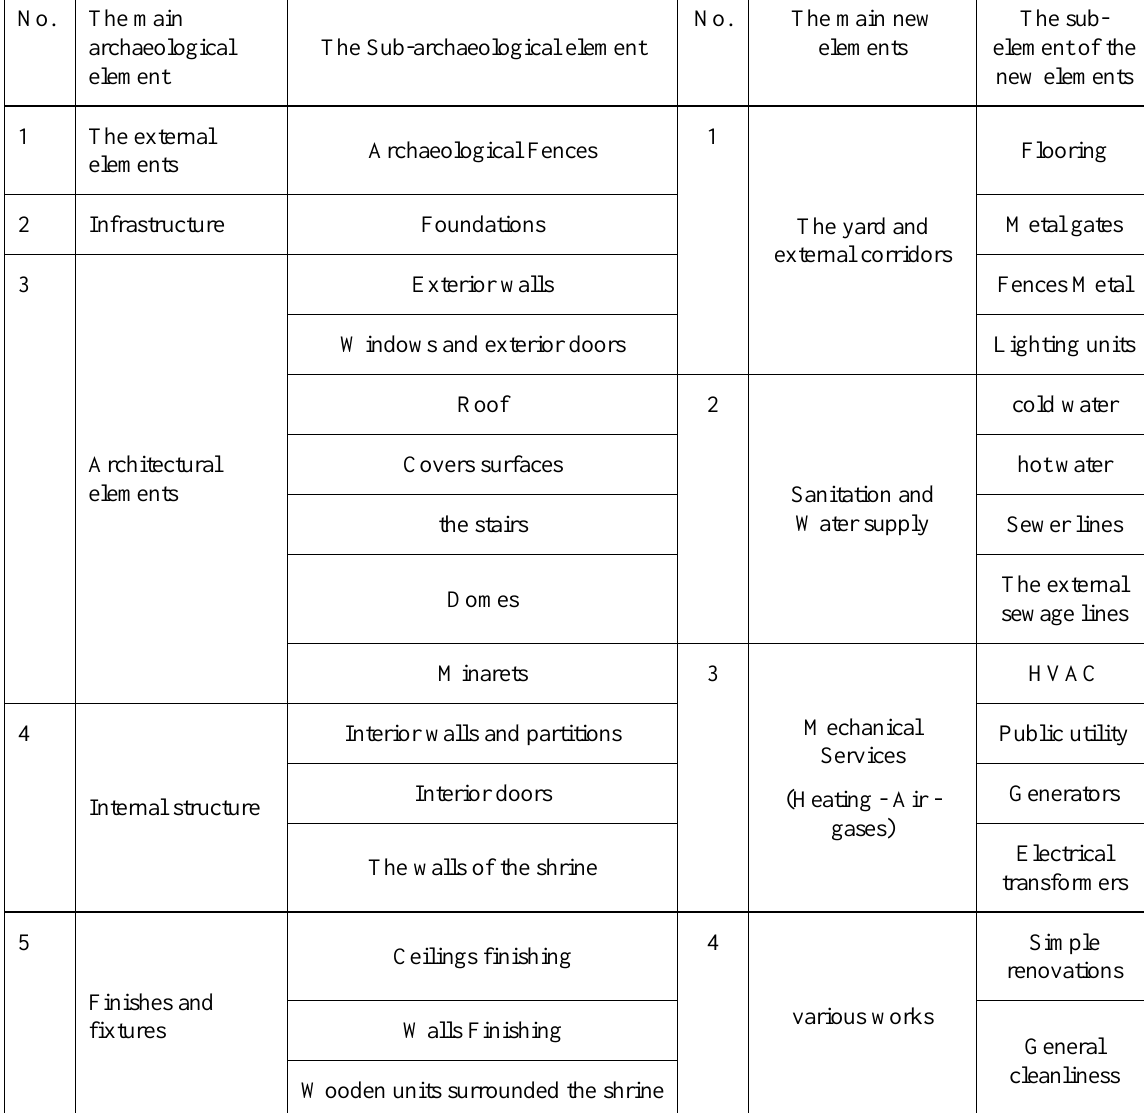
Figure 1. Interior & Exterior Pecture to the Mosque of Abul-Hajjaj in